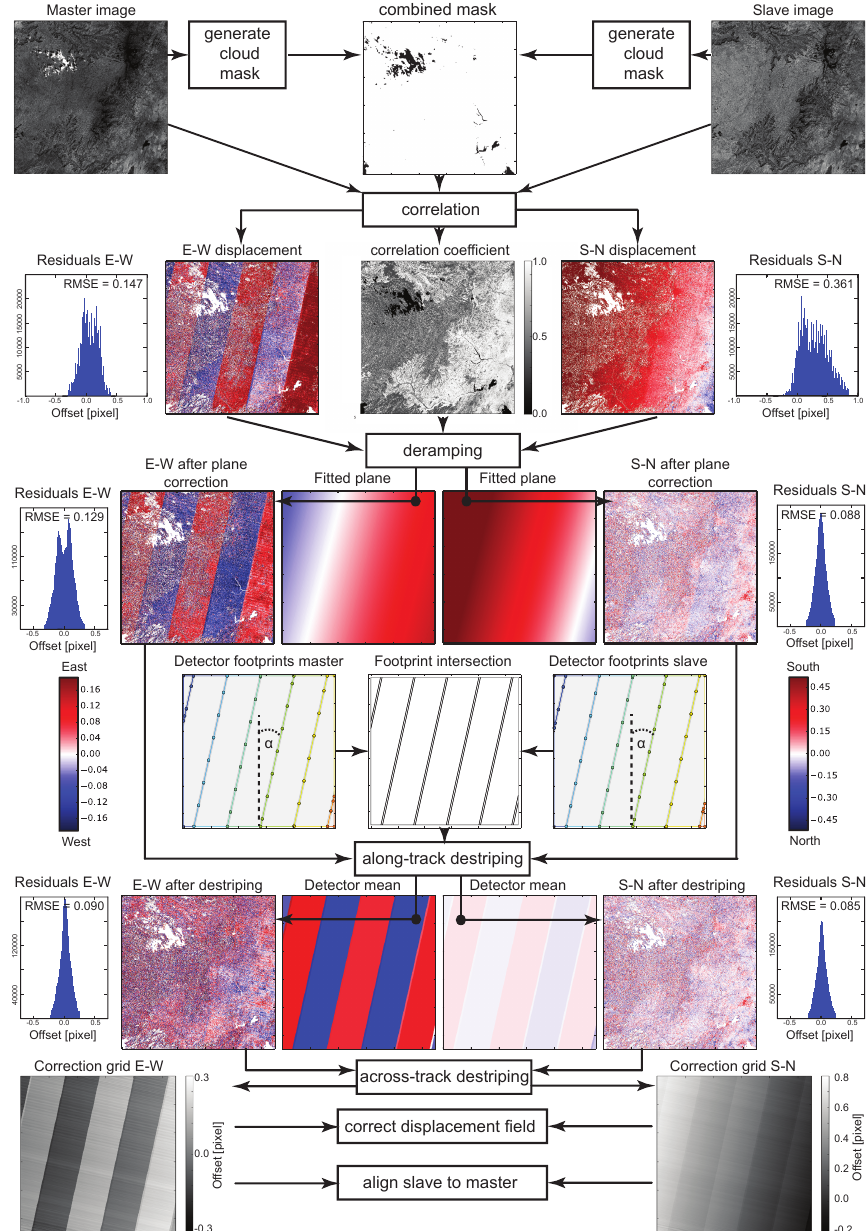
Figure 1. coregis processing chain illustrated for two Sentinel-2 scenes (T37PEL 28 January 2016 and 19 January 2017). For the case of Landsat-8 to Sentinel-2 co-registration, the ground track azimuth α is computed from detector footprint of the respective Sentinel-2 master